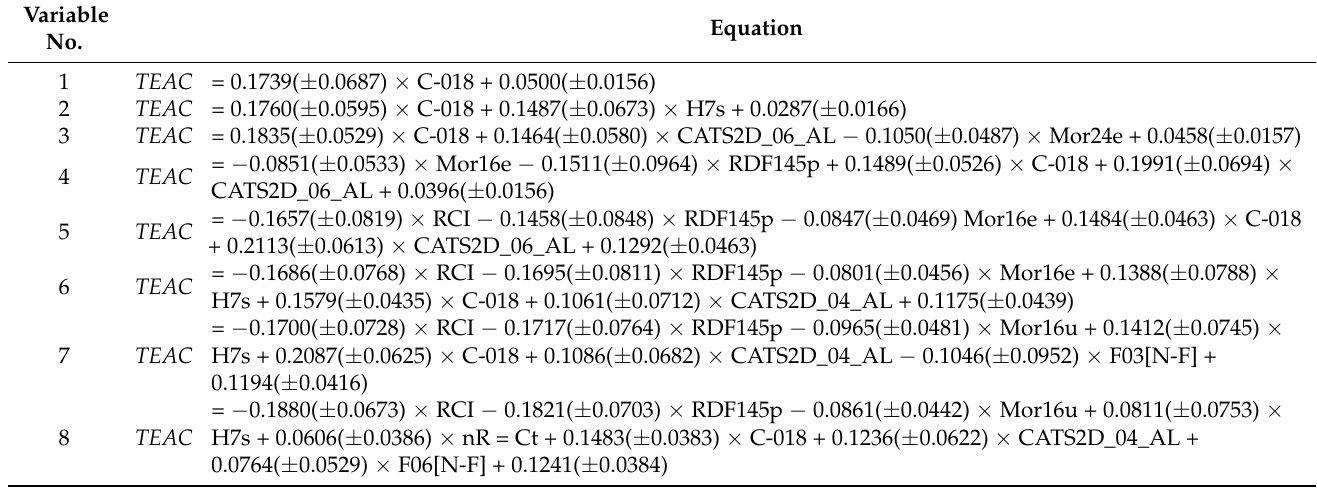
Table 2. Selected 1- to 8-variable models for prediction of TEAC on the training set.